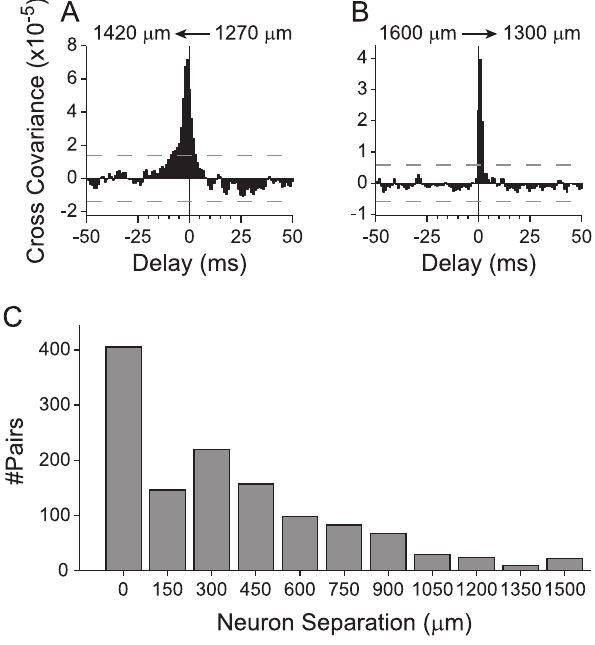
Figure 11. Putative monosynaptically connected neurons. Connections were classified as monosynaptic if peak delays were 1– 4 ms, and if cross-covariance function halfwidths were less than 10 ms. (A,B) Examples cross-covariance functions for two putative monosyn- aptically connected neurons. (A) Functional connection between two cells in layer 5. The direction of the connection is from the cell at 1270 m m to the cell at 1420 m m. (B) Functional connection from a cell in layer 6 (1600 m m) to a cell in layer 5 (1300 m m). (C) Vertical distance between neurons for all monosynaptic connections (N=1203 pairs).